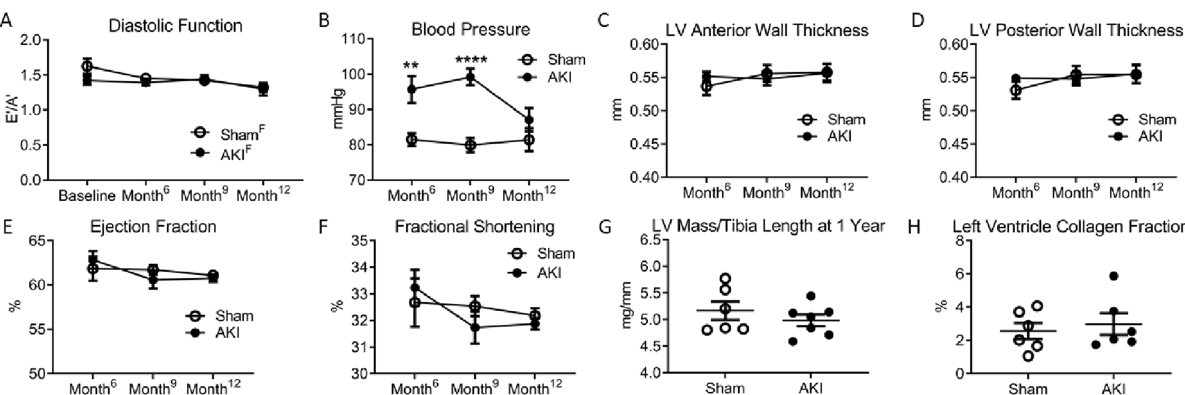
Figure 4. Cardiovascular assessment in females after AKI. ( A ) Females with or without AKI had preserved diastolic function throughout the 1 year study. ( B ) Cohorts who underwent AKI had elevated mean arterial blood pressure measurements compared to sham cohorts 6 and 9 months after procedure, but there was no significant difference in blood pressure between the two cohorts at 1 year. ( C ) There was no difference between AKI and sham cohorts left ventricle (LV) end diastolic anterior ( C ) or posterior ( D ) wall thickness, ejection fraction ( E ) or fractional shortening ( F ) throughout the study. There was no difference in LV mass corrected for tibia length ( G ) or LV collagen fraction (H) 1 year after AKI or sham. (n = 5–7) **P < 0.01; ****P <